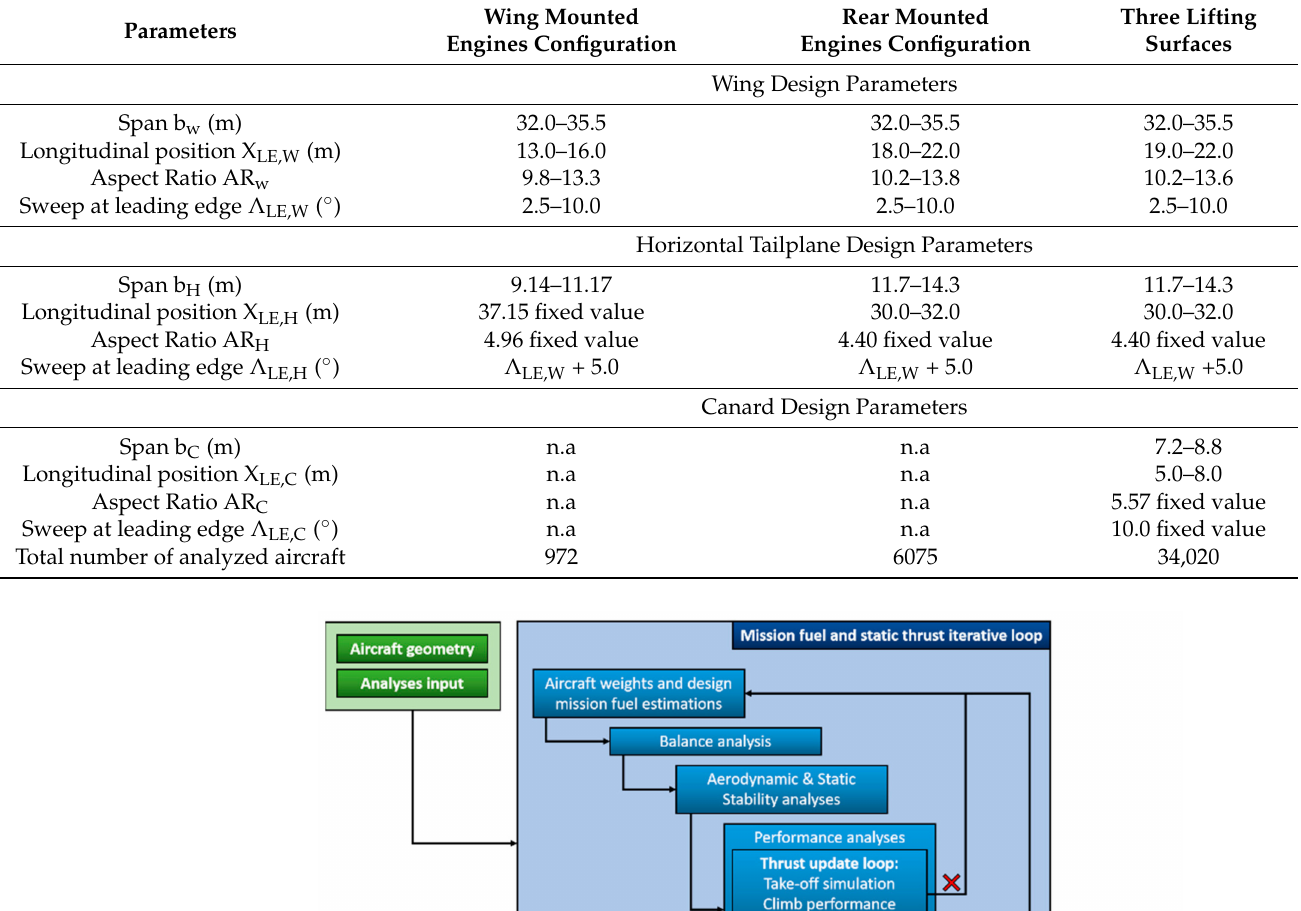
Table 2. Variables design space for each aircraft configuration.